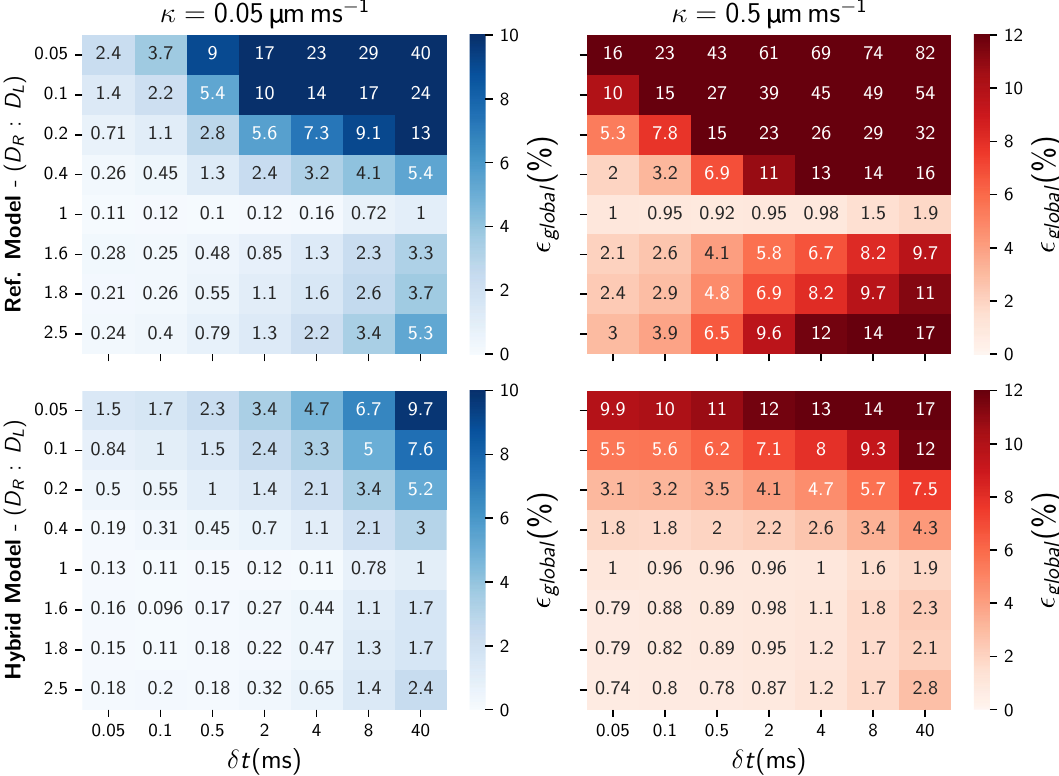
trates the distribution of cell sizes for the manual and automatic segmentation 30 . As explained in ”The diffu- sion problem applied to a synthesised histology-based domain”, we recreate a histology-based domain by con- sidering circular cross-sections for cardiomyocytes. The segmentation data shows a mean cross-sectional area 120 µ m 2 and a standard deviation of σ 40 µ m 2 . We utilise these parameters to create a synthesised of µ = = 2 σ ) for the intra-cellular space and a uniform dis- histology-based domain using a normal distribution ( µ ± tribution (3– 5 µ m ) for the extra-cellular compartments. The resulting domain is recreated by drawing both intra-cellular and extra-cellular distributions until reaching a total length of 49.5 µ m . Figure 7 shows the final steady state and three different transient states for the histology-based domain. The transient states are analysed 50, 100, and 1000 ms considering that all the particles are initialised in at three different diffusion times T =